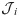
Structure of the feedforward and recurrent generative models used in our computational experiments.(A) The feedforward network model of primary motor cortex (M1) is borrowed from Ref. [4] and produces heterogeneous hand-location tuning curves. This heterogeneity is rooted in the random network structure, including the variability in the input layer (modeling a premotor or parietal area) receptive field widths, σi, feedforward weights to the M1 layer, Ji, and the threshold, ϕ, of M1 output neurons which are rectified linear units. (B) The structure of the Stabilized Supralinear Network (SSN) with one-dimensional topography (retinotopy) as a model of the primary visual cortex (V1). The SSN is a recurrent network of excitatory (E) and inhibitory (I) neurons. The visual stimulus (bottom) models the input to V1 due to a grating of diameter bs in condition s. Heterogeneity in model output (size tuning curves) originates in the heterogeneity of feedforward and recurrent horizontal connections. The mean and variance of the horizontal connections between SSN neurons depend on the pre- and postsynaptic cell-types and their retinotopic distance, and for different connection-types falloff over different characteristic length scales. For a full description of models and their parameters see Materials and methods.